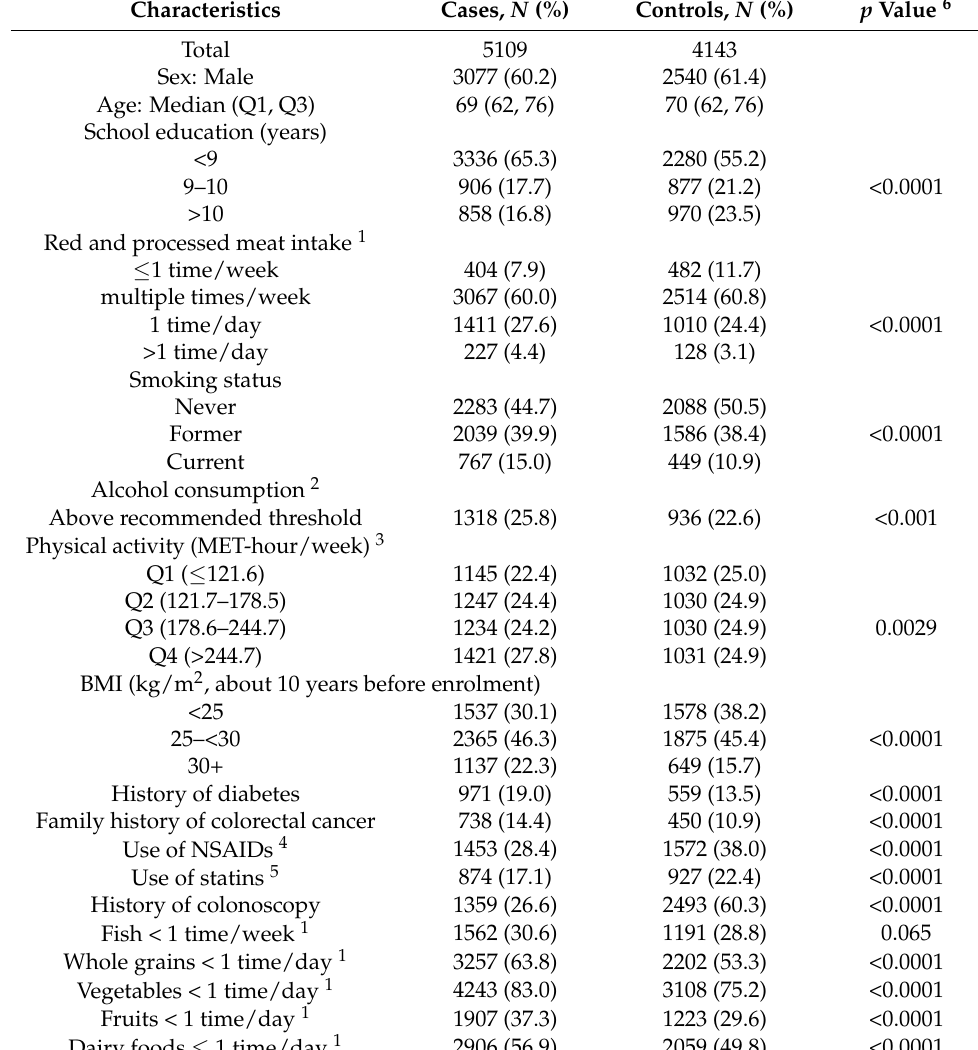
Table 1. Baseline characteristics of colorectal cancer patients and